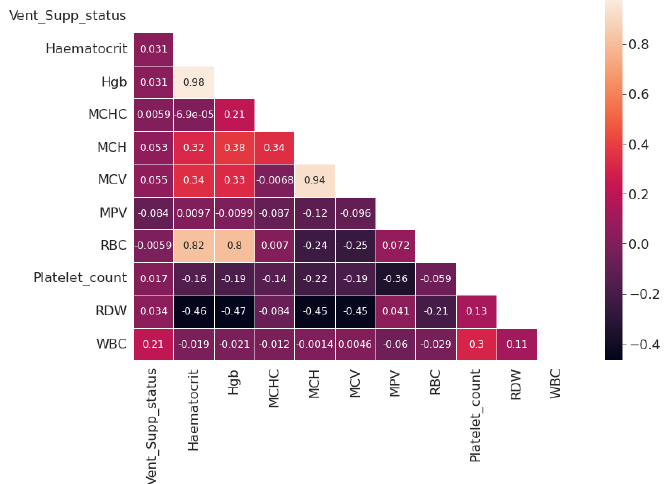
Figure 6. Correlation map for the Complete Blood Count attribute.